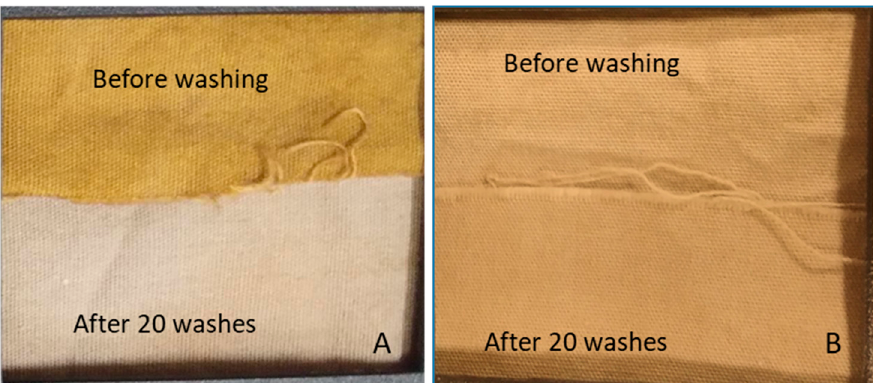
Figure 2. Washing durability of cotton fabric treated by AgNP by in situ synthesis by reacting 2 mM AgNO 3 with 20% ( w/v ) Azadirachta indica leaf extract in a ratio of 9:1 at pH 7.1. ( A ) Un-mercerized sample. AgNP synthesis at room temperature. ( B ) Mercerized sample. AgNP synthesis at hydrothermal